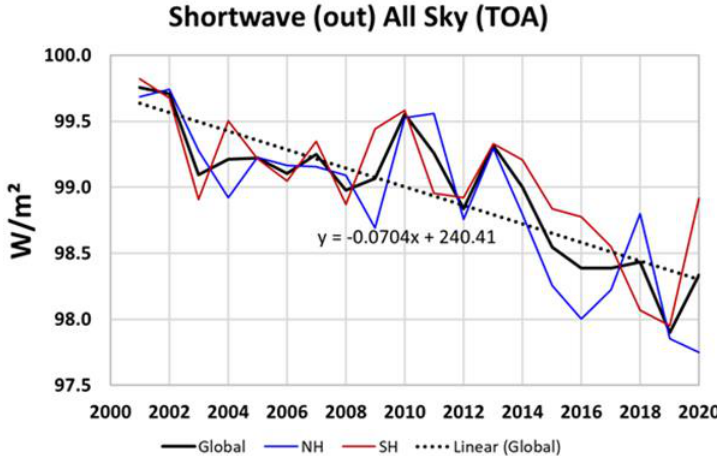
Figure 3. The declining trend of the outgoing SW flux at TOA. The average effect is − 1.4 ± 0.2 W/m 2 for two decades, stronger than both effects shown in Figures 1 and 2 combined. Other than above, there are no significant differences between NH and SH.